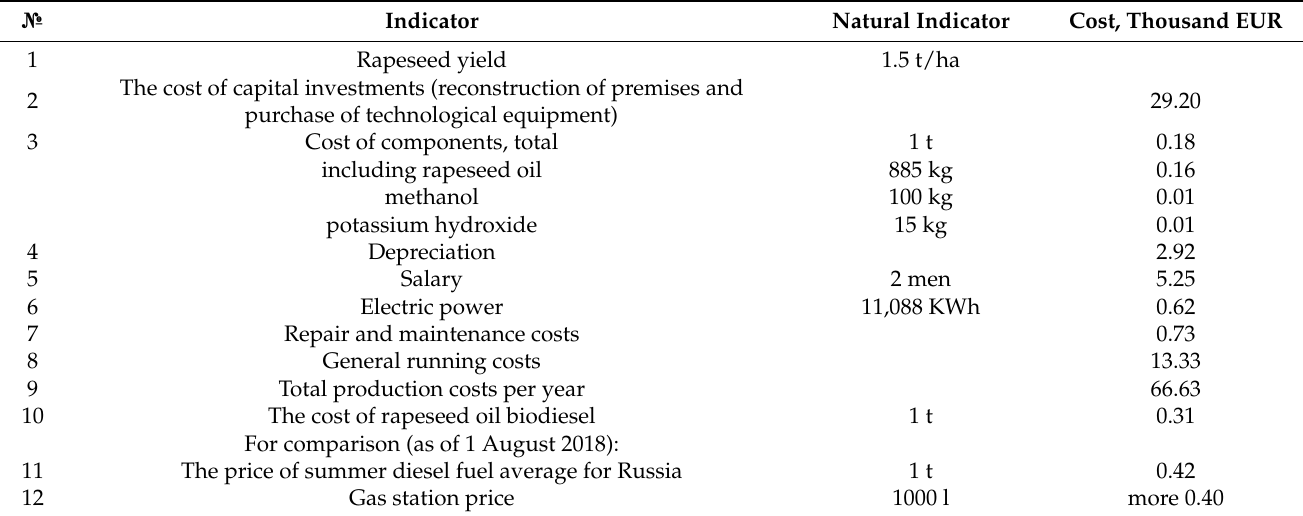
Table 7. Formation of the cost of biodiesel from rapeseed